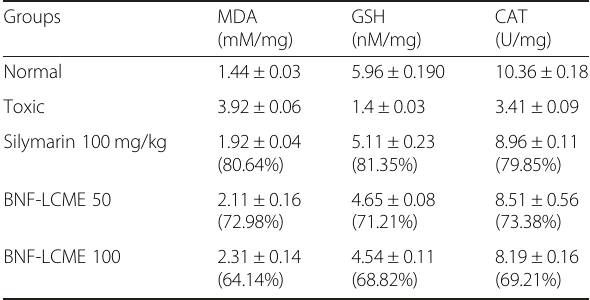
Table 5 The effect of BNF-LCME on in vivo antioxidant parameters against D-Galactosamine induced hepatic damage in rats